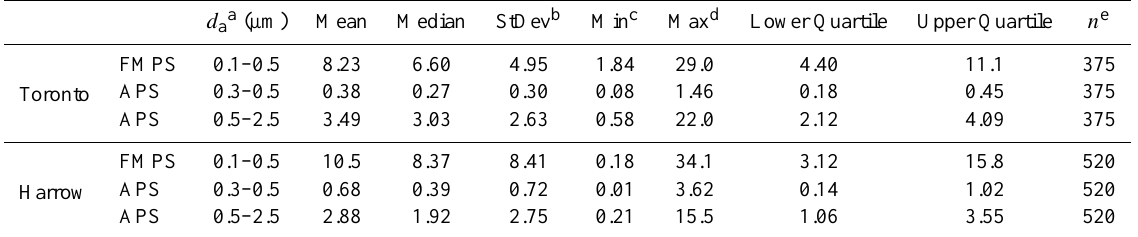
Table 1. Descriptive statistics for hourly averaged particle volumetric concentrations (µm 3 cm − 3 ) measured by the FMPS and APS during the SPORT in Toronto and the BAQS-Met in Harrow. d aa (µm) Mean Median StDev b Min c Max d Lower Quartile Upper Quartile n e FMPS 0.1–0.5 8.23 6.60 4.95 1.84 29.0 4.40 11.1 375 APS 0.3–0.5 0.38 0.27 0.30 375 Toronto APS 0.5–2.5 375 FMPS 0.1–0.5 10.5 8.37 8.41 APS 0.3–0.5 0.68 0.39 Harrow